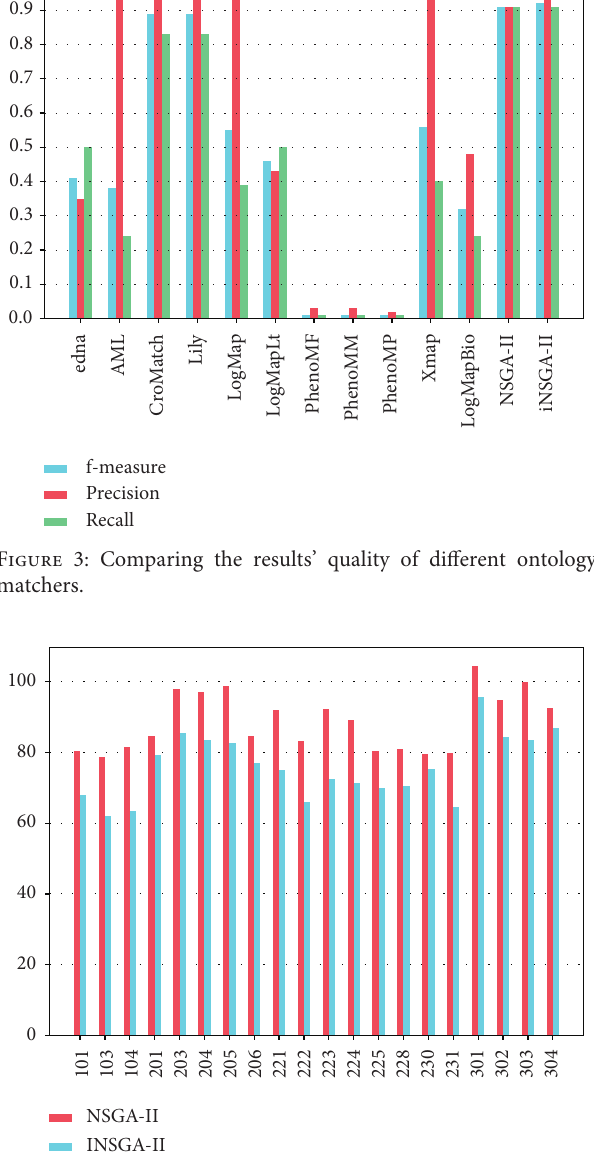
Figure 4: Comparison of evaluation times of the f -measure value reaching